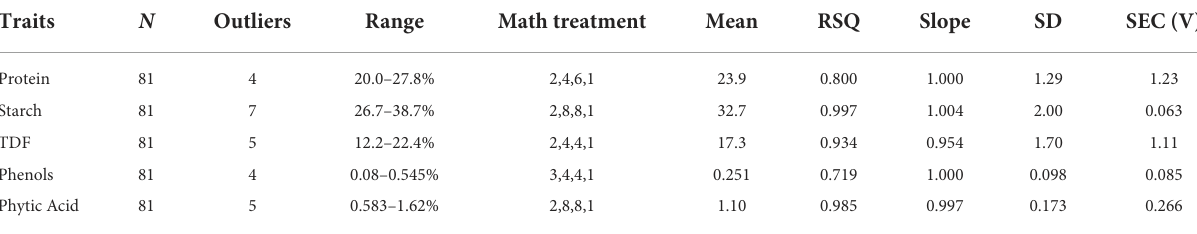
TABLE 2 Calibration statistics of 81 cowpea accessions.